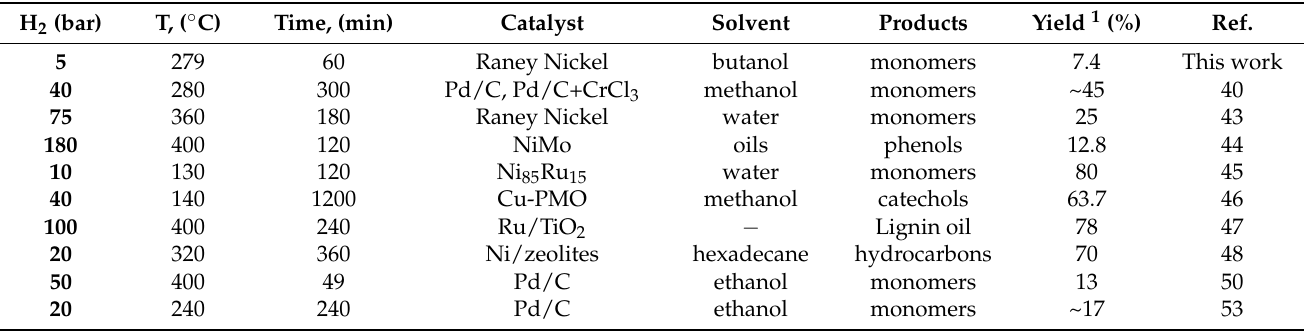
Table 5. Literature review of organosolv lignin hydroprocessing.